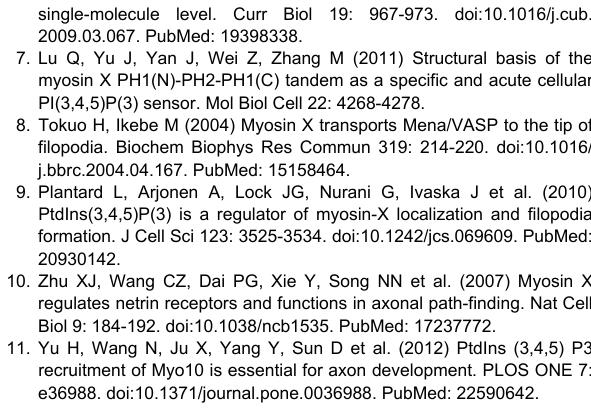
Figure S5. Movement of m5-HMM and m10 HMM-Zip on fascin-F-actin and α-actinin-F-actin rafts. In all panels the left image shows 2D bundle of F-actin labeled with rhodamine phalloidin and colored red. The yellow lines in each of these images were analyzed for the kymographs which are shown in the right panels. (A and B) Fluorescence images of